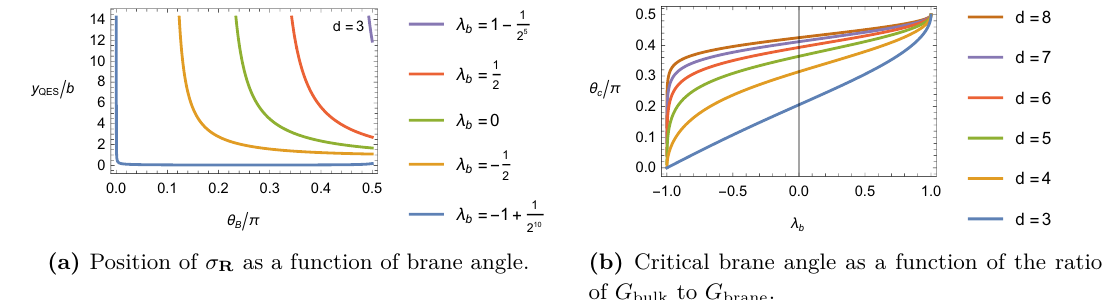
Figure 22. Plots of the position of σ R , the intersection of the RT surface with the brane, and the critical brane angle at which this surface runs off to y QES → + ∞